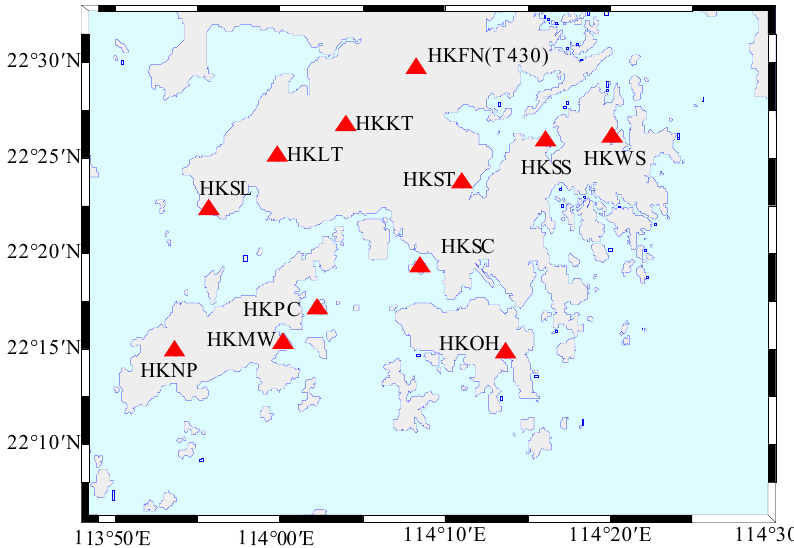
Figure 1. Distribution of the GPS reference stations in the Hong Kong area.